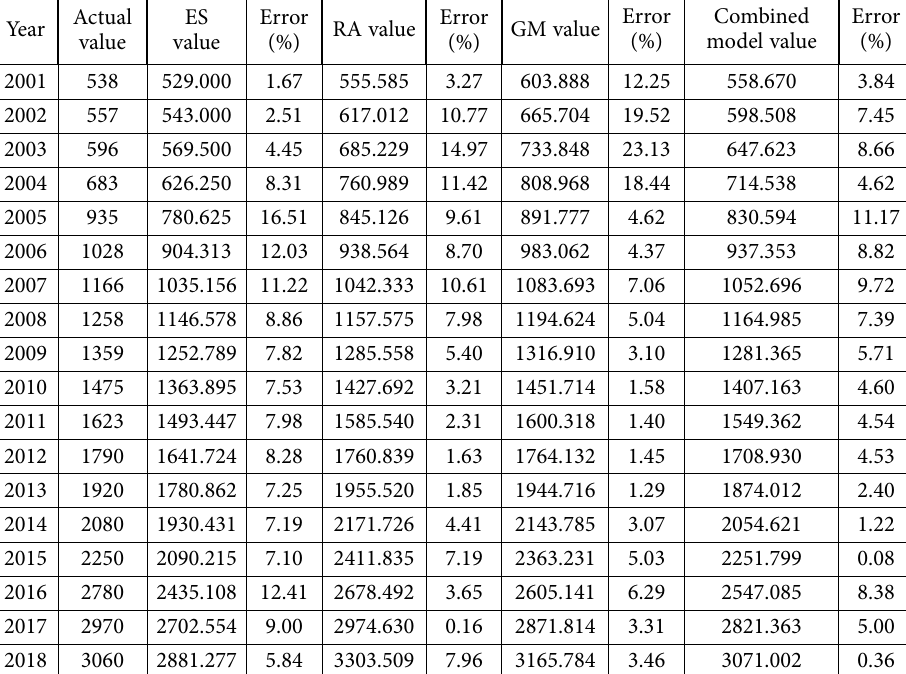
Figure 4. Comparison of the forecasting values for three models and the actual Table 8. Forecasting value of the logistic demand of the green tea industry from 2000 to 2018